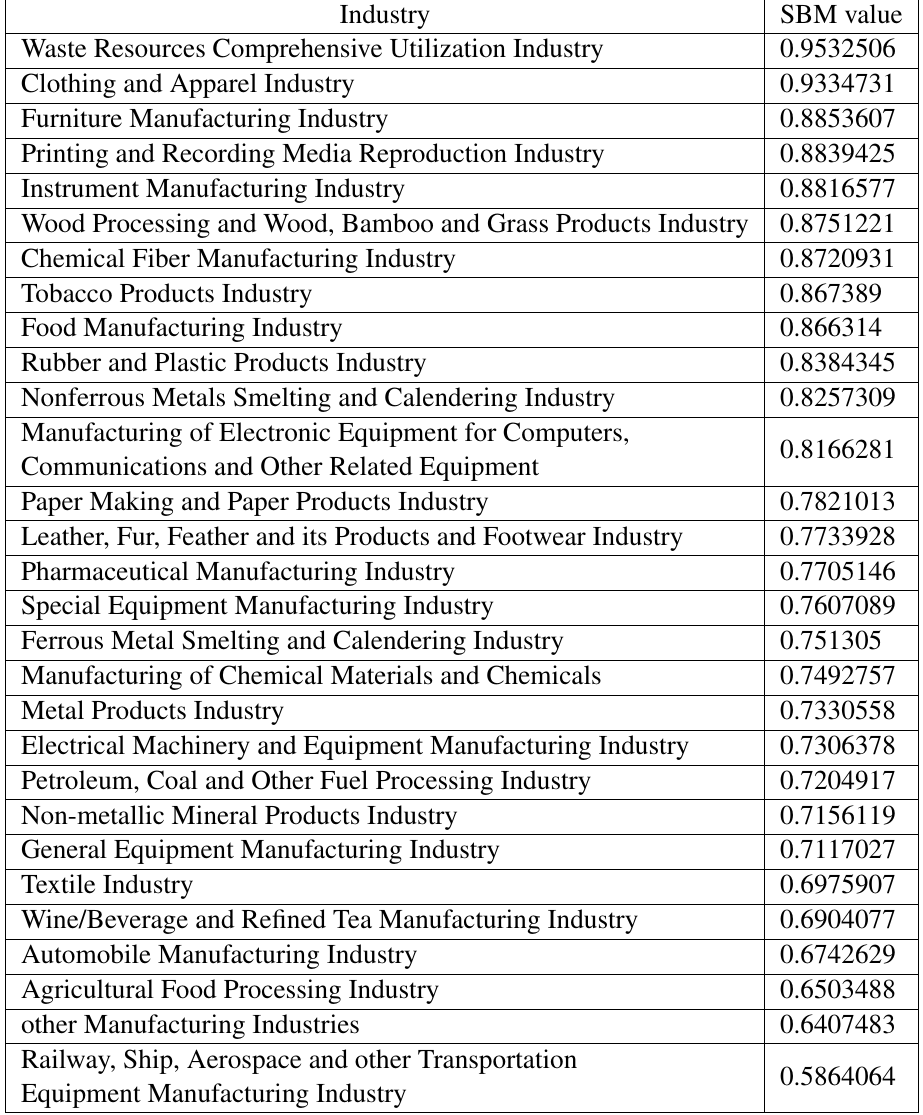
Table 3 Average integrated technical efficiency of various